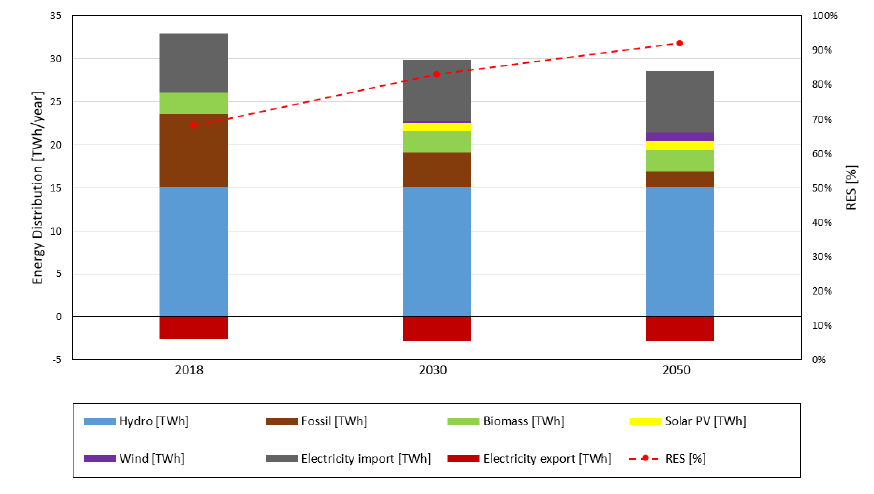
Figure 5. Energy